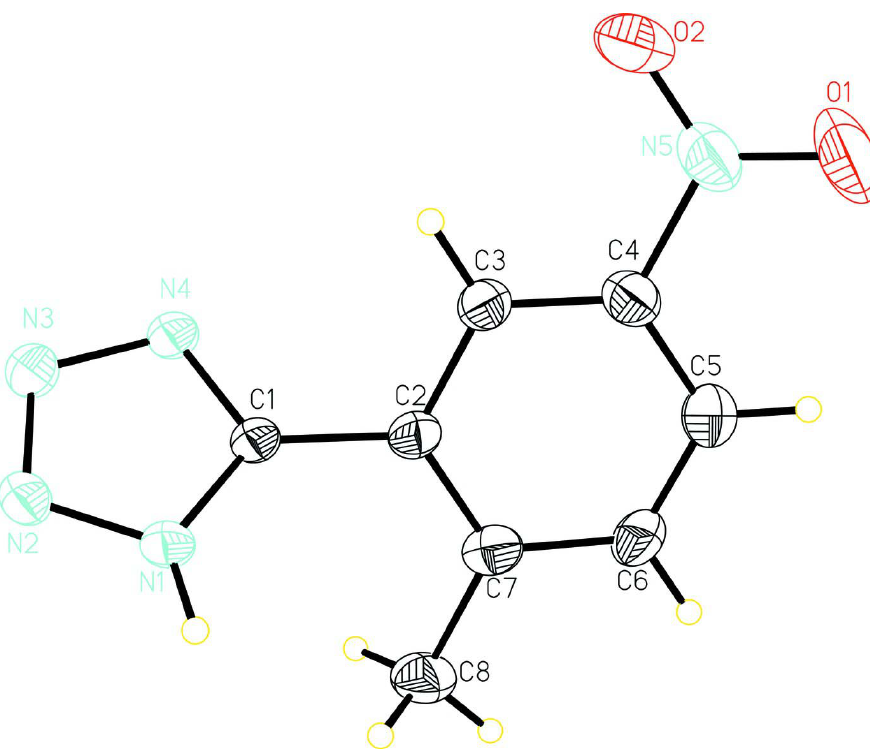
Figure 1 The molecular structure of the title compound, showing the atomic numbering scheme. Displacement ellipsoids are drawn at the 30% probability